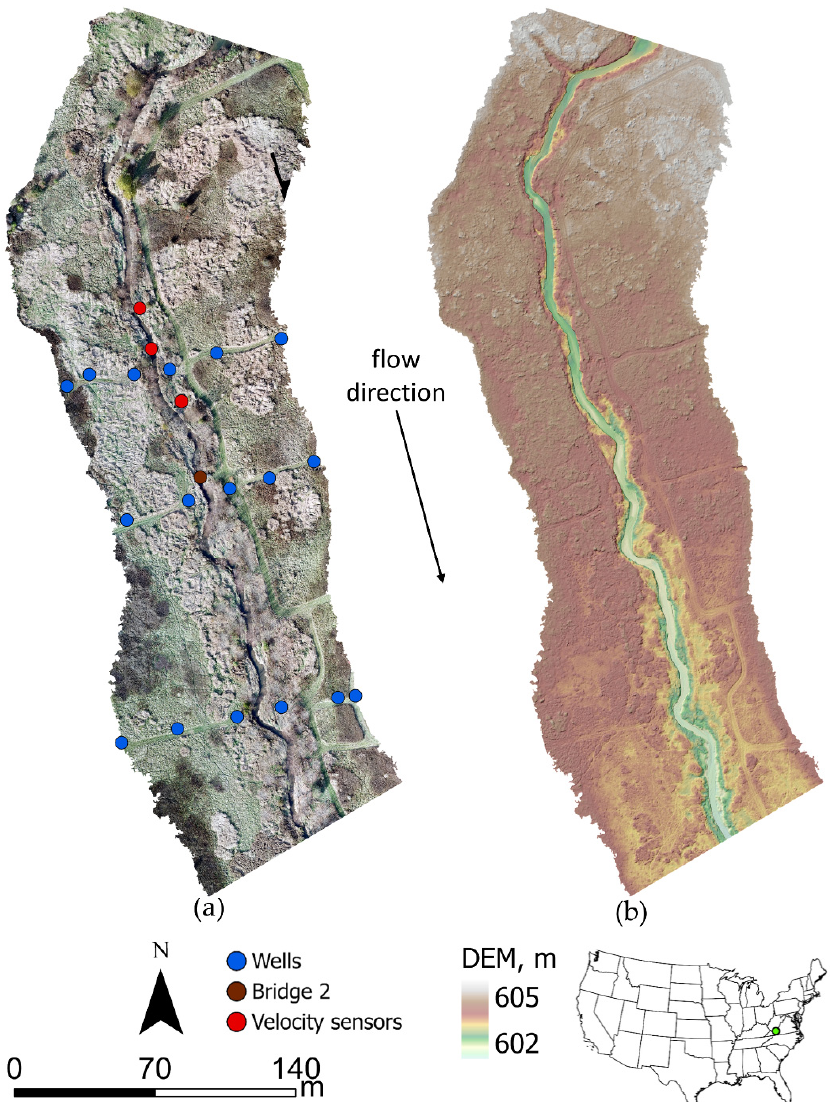
Figure 1. StREAM Lab map: ( a ) orthophoto with important in situ data collection locations denoted, ( b ) digital elevation model of StREAM Lab created from the DLS point cloud.